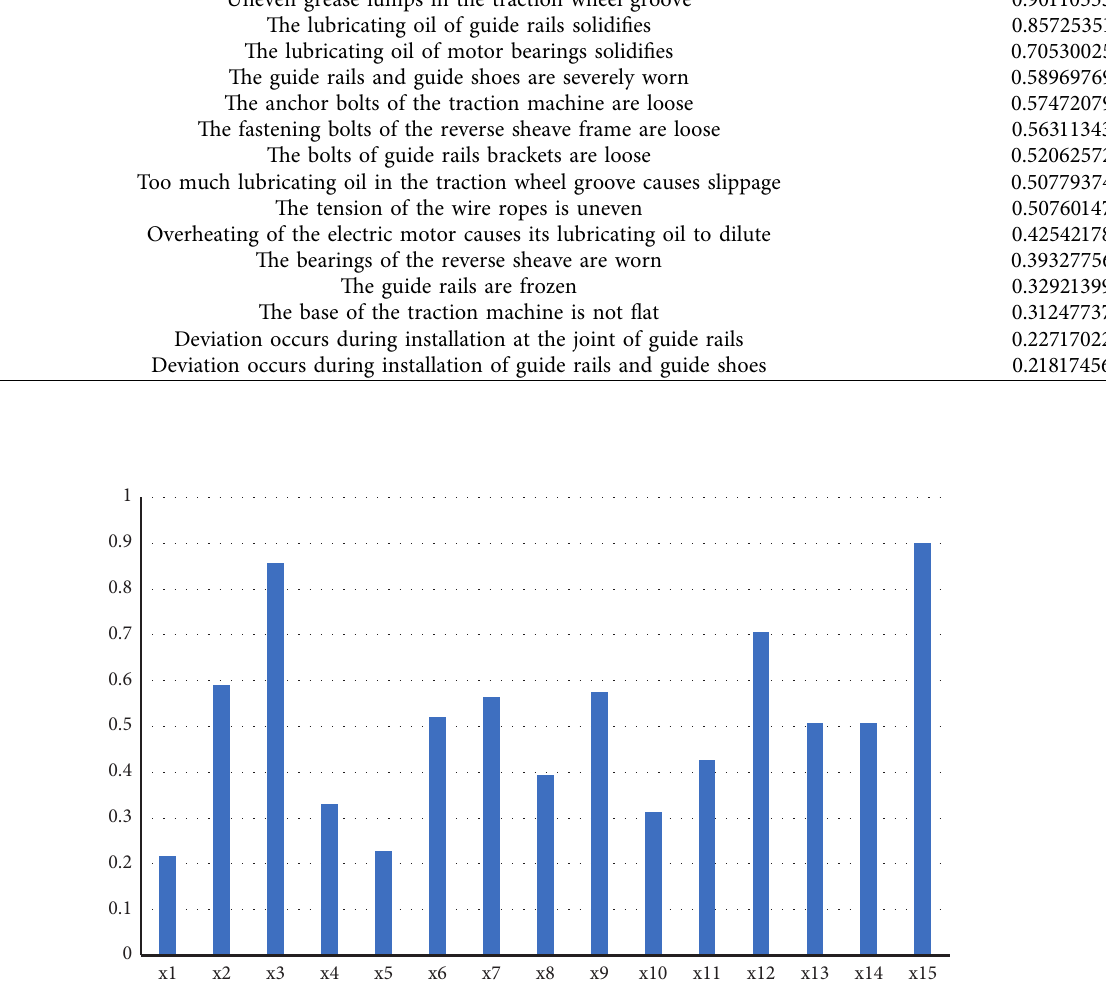
Figure 5: The ranking results of the static attributes.